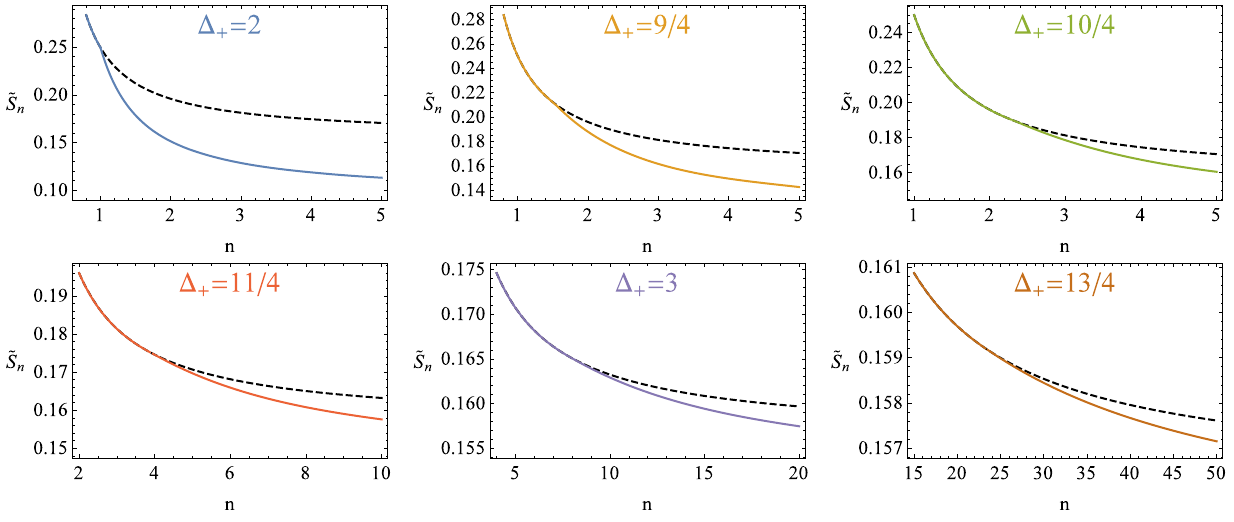
Fig. 4 Each diagram shows the behavior of the Rényi entropies for EBH (dashed curve) and HBH for various values of the (cid:16) + . Two curves meet each other at a critical number, n